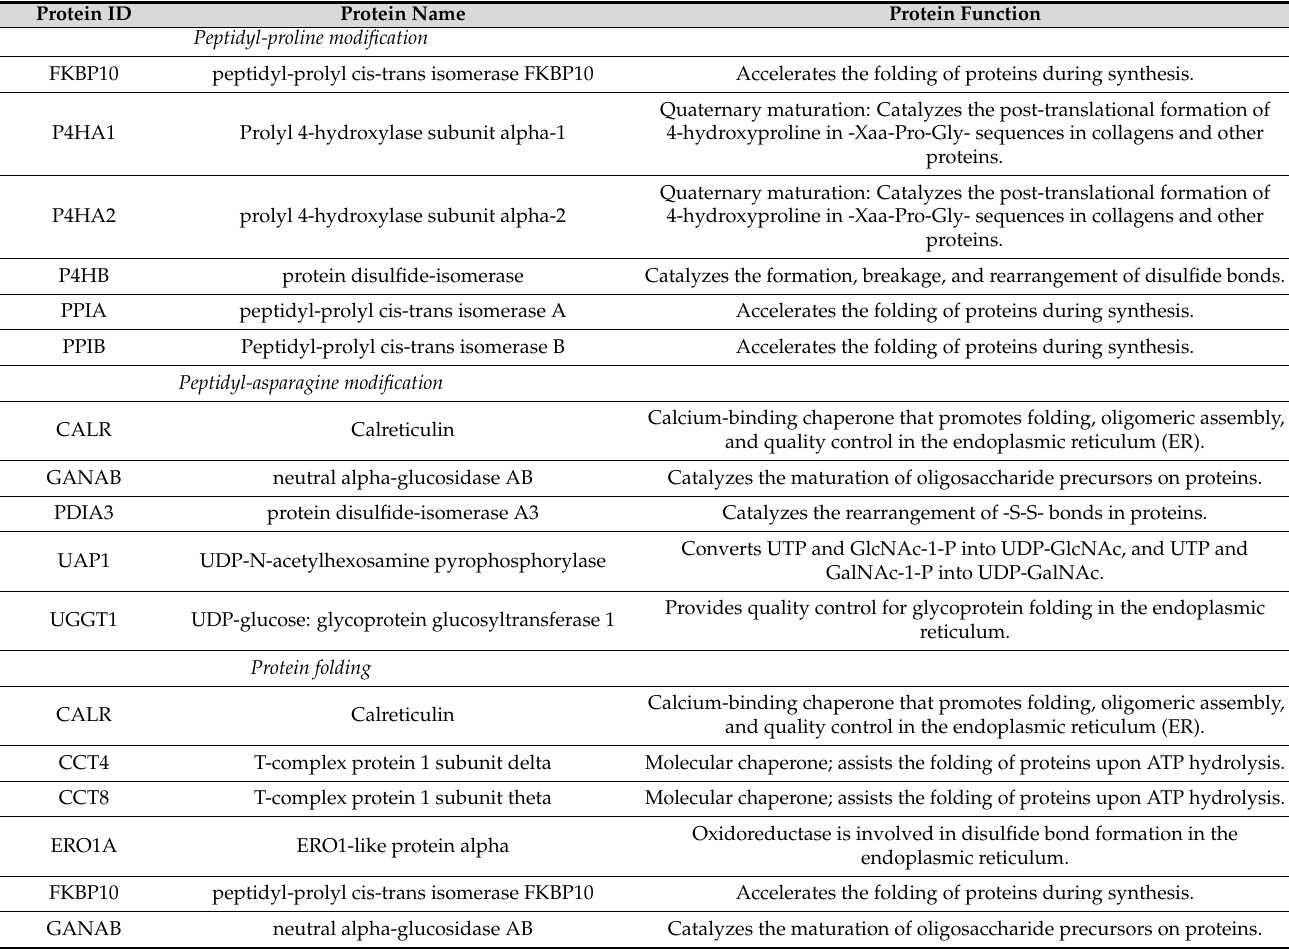
Table 1. Proteins which expression was maintained throughout the course of hypoxia/hypothermia and reoxygenation. Protein